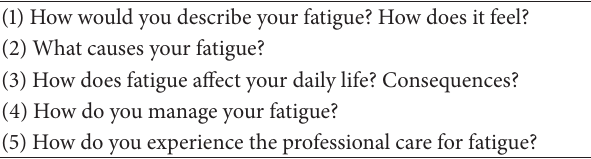
Table 2: Interview guide for fatigue in IBD: the topics for the semi- structured